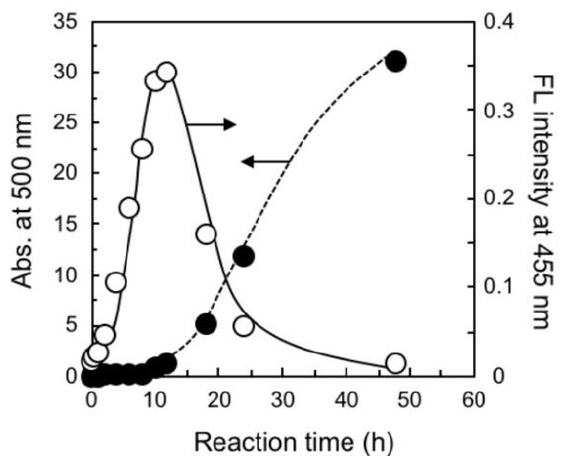
Figure 3. Time courses of the absorbance increase (solid circles) at 500 nm and the fluorescence change (open circles) at 455 nm upon excitation at 400 nm in the polymerization of DHN with TMTA. The polymerization condition is summarized in P h -1 of Table 1.